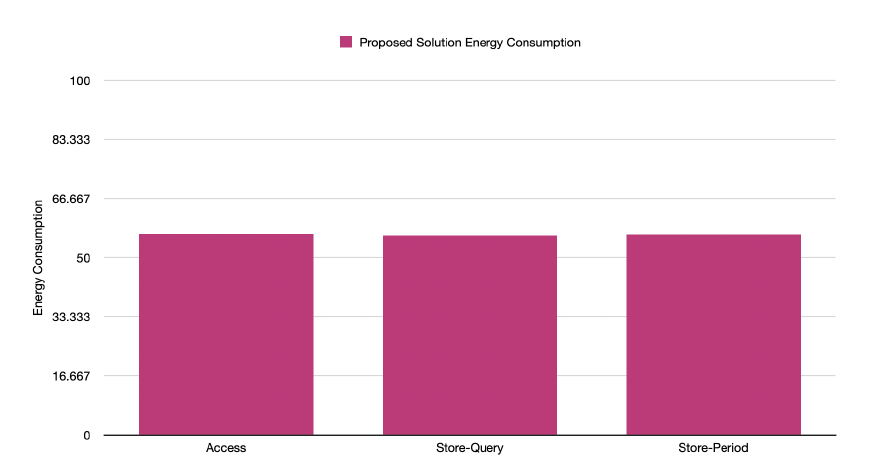
Figure 11. Energy consumption overhead (Lx) of healthcare